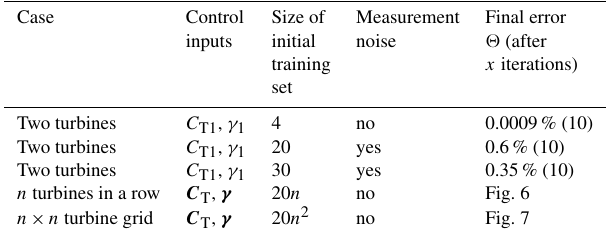
Table 1. Overview of the case studies.